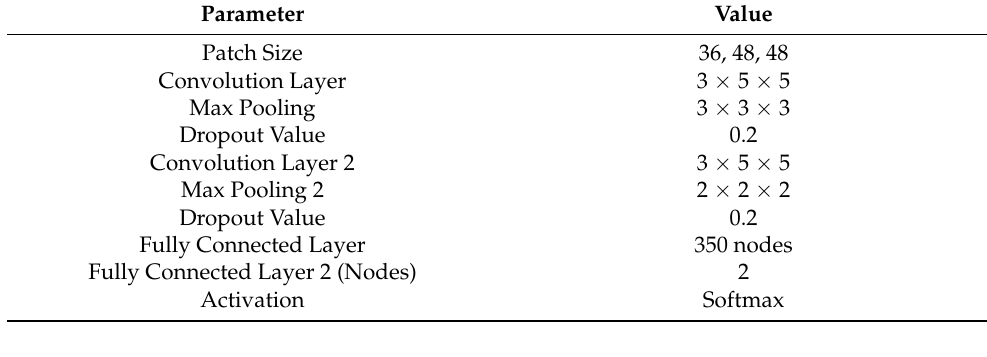
Table 1. Proposed CNN architecture for efficient lung nodule classification.